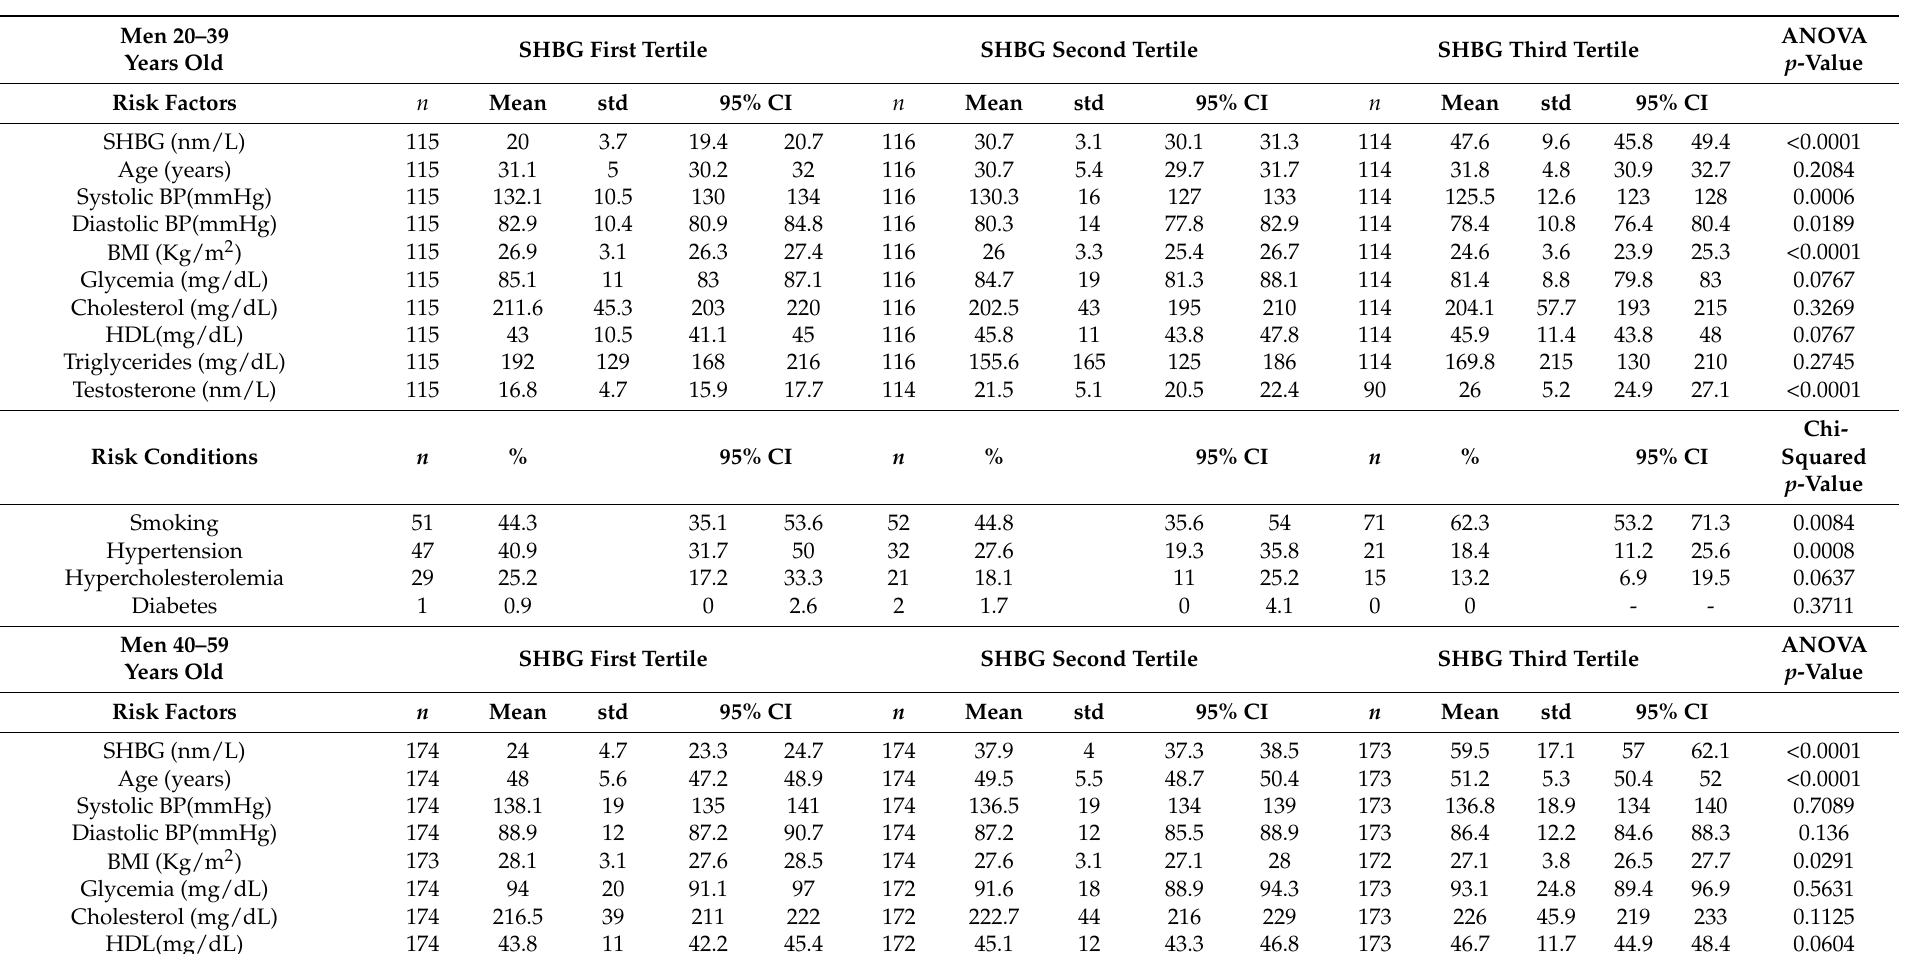
Table 3. Baseline characteristics by Sex Hormone-Binding Globulin (SHBG) tertiles and age groups. The Malattie Aterosclerotiche Istituto Superiore di Sanit à